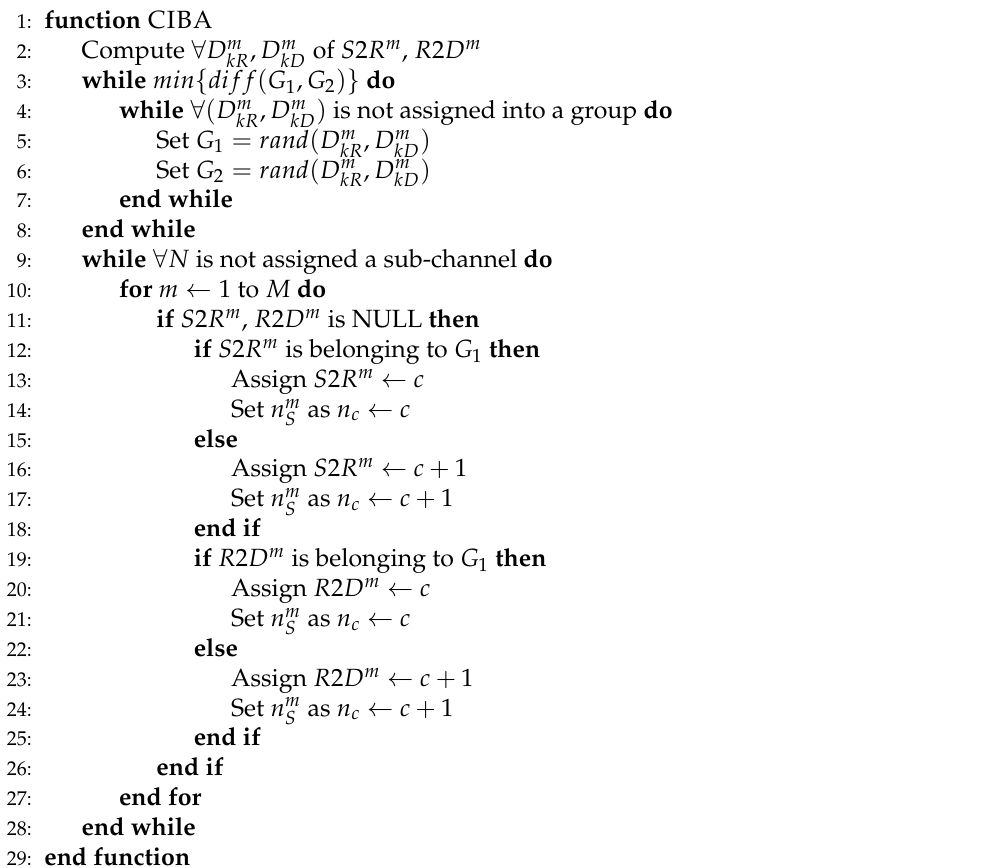
Algorithm 5 Channel Interference Balancing Allocation